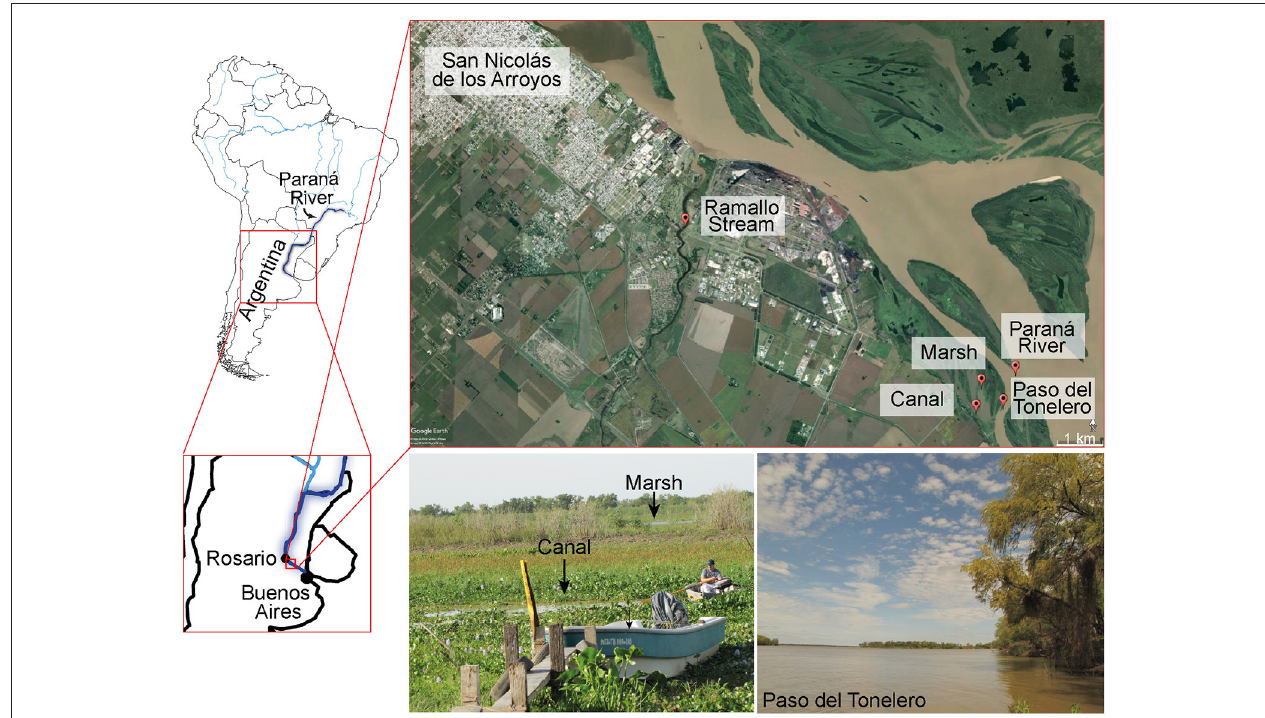
FIGURE 1 | Localization of the sampling sites in the Middle Paraná River, Argentina. The five sampling sites are located near San Nicolás de los Arroyos, in the north of Buenos Aires Province, Argentina. Out of five sites, 4 were located in the Paraná River (Paraná River, Paso del Tonelero, Marsh and Canal), while Ramallo Stream is a small tributary of it. Specific cartographic data for each site can be found in Supplementary Table.